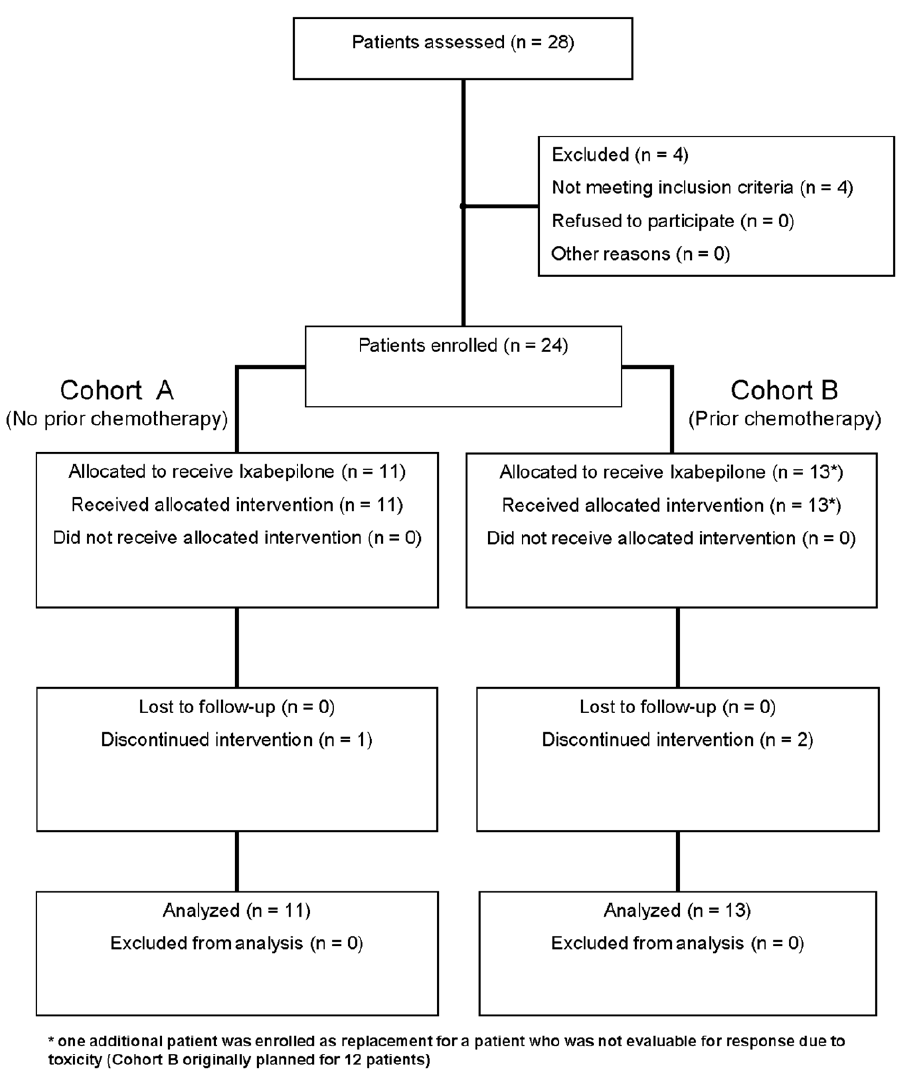
Figure 1. Consort diagram.